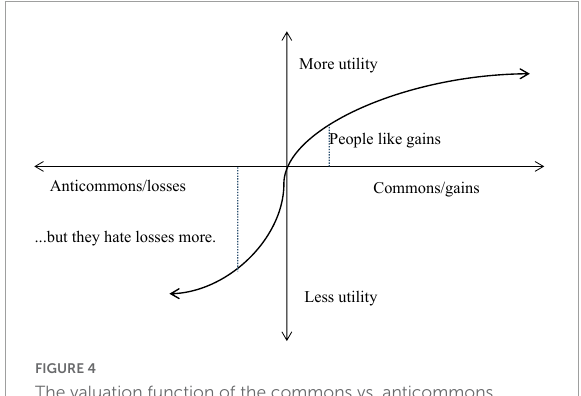
FIGURE4 The valuation function of the commons vs. anticommons.